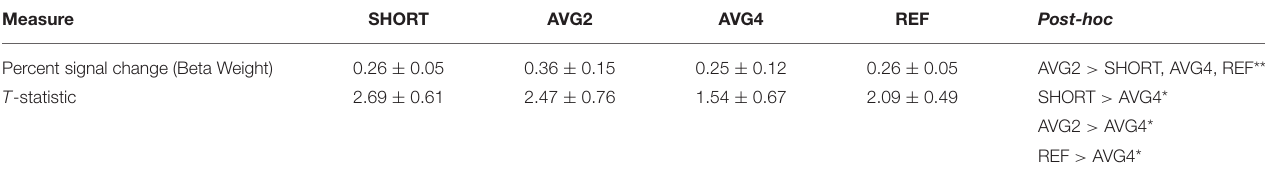
TABLE 1 | Post-hoc results for the BOLD signal change and GLM-calculated T- statistics for the ROI mask containing only task-related regions. Measure SHORT